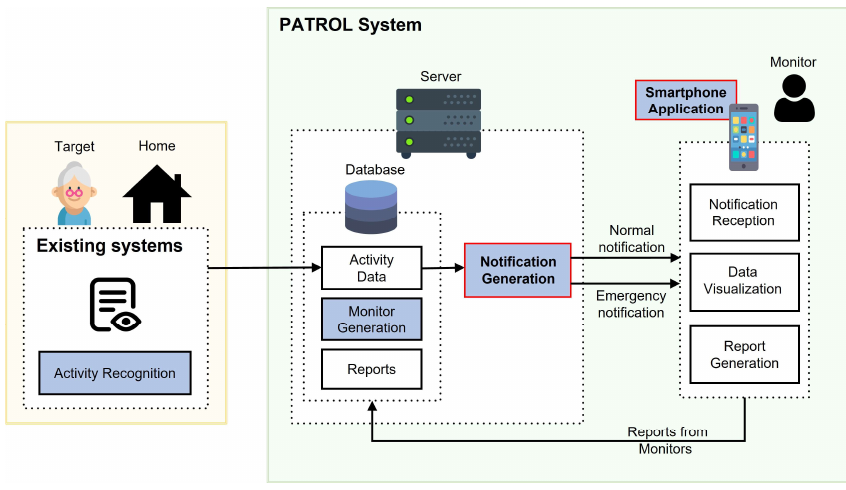
Figure 1. System architecture of